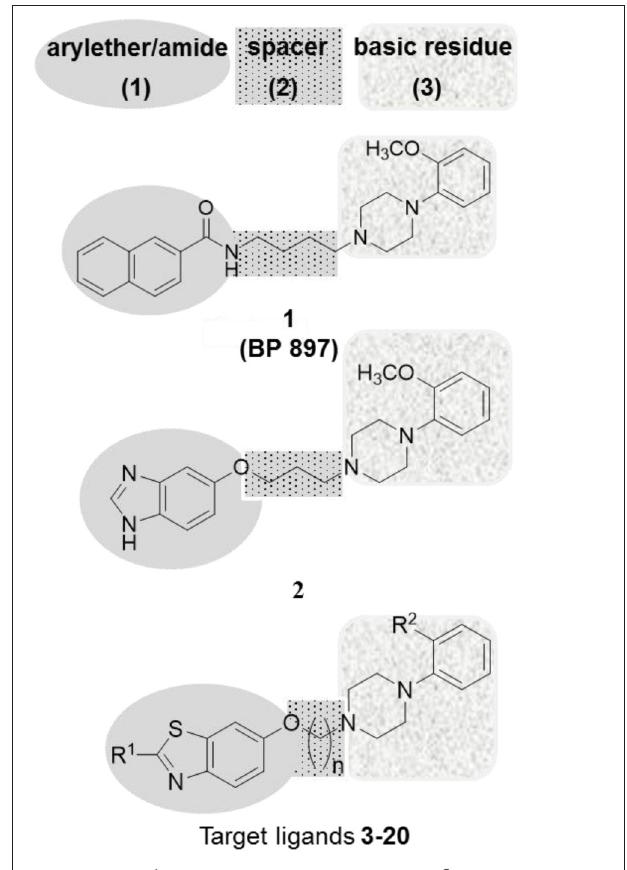
FIGURE 1 | Features similarities between the lead structures 1 , 2 and target compounds ( 3-20